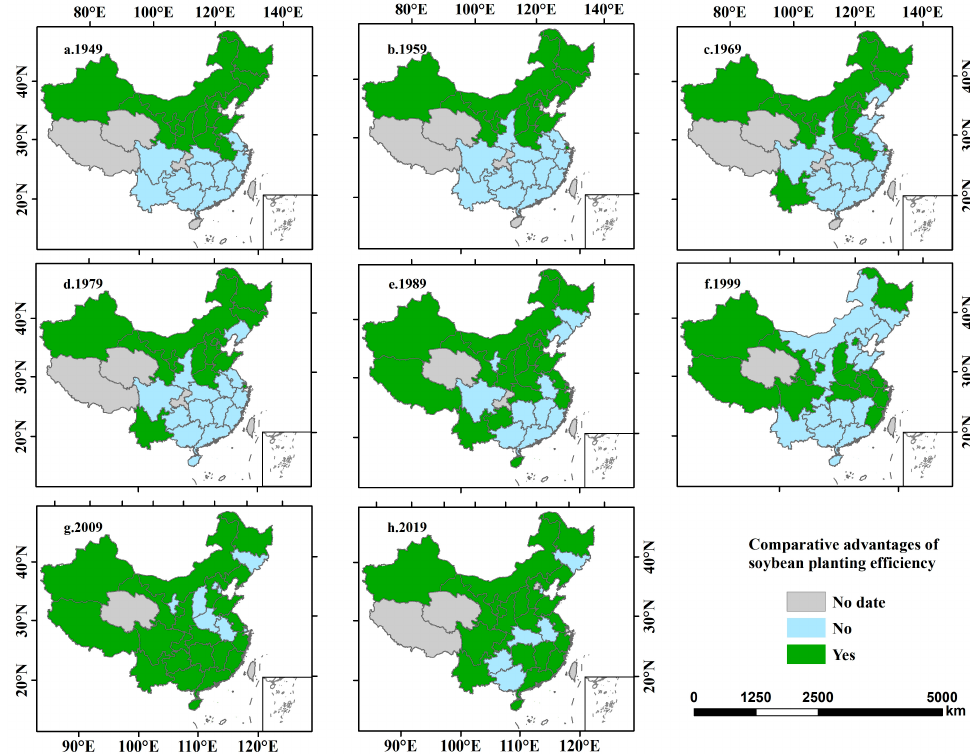
Figure 5. Spatial distribution of the comparative advantages in soybean planting efficiency in China from 1949 to 2019.